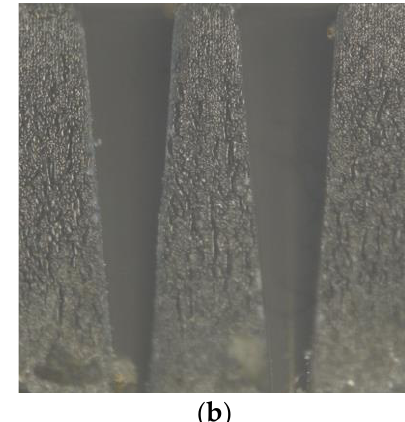
Figure 8. Online tuning platform based on femtosecond laser.